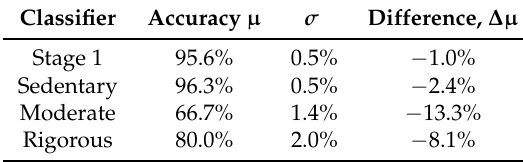
Table 5. On-Board Classification (effect of tree and split reduction).